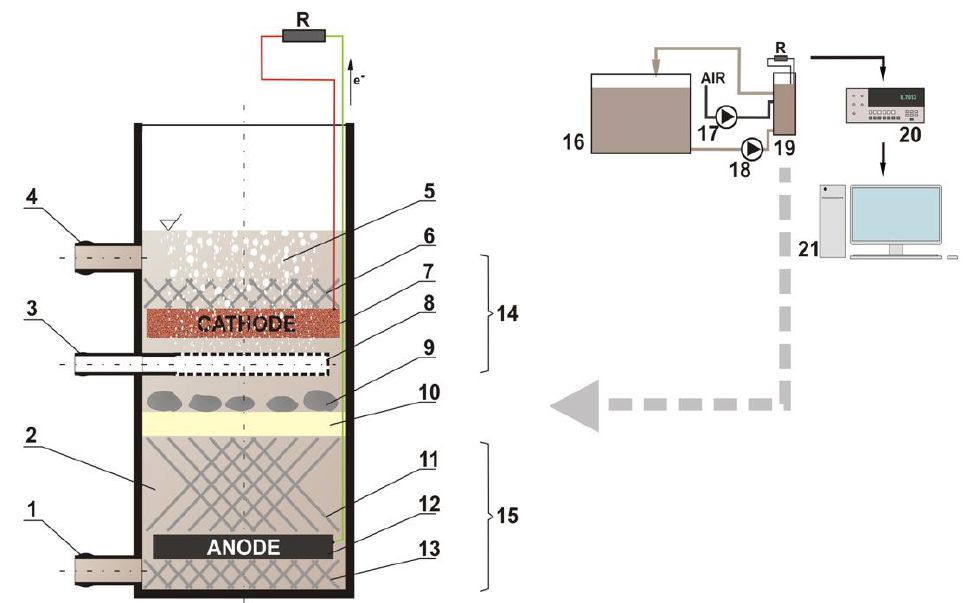
Figure 1. Scheme of the membrane-less microbial fuel cell (ML-MFC) and measuring setup for mea- suring electrical parameters during operation of ML-MFC: 1—wastewater intake (from wastewater